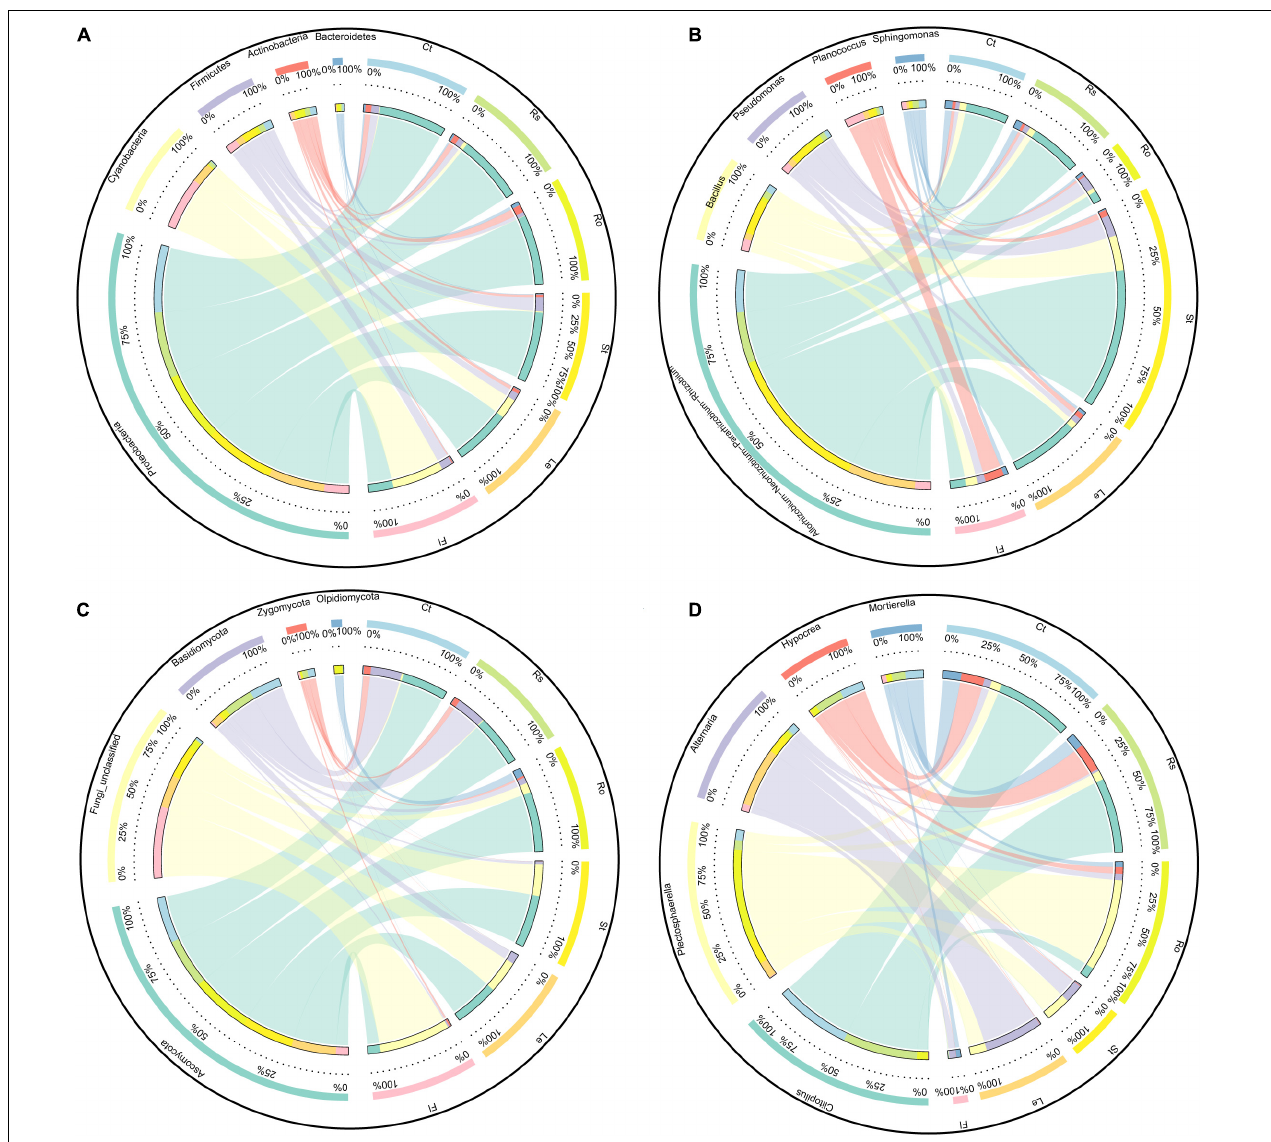
FIGURE 3 | Circos plot showing the distribution proportion of core microbiota among plant compartments. (A) Core bacterial phyla. (B) Core bacterial genus. (C) Core fungal phyla. (D) Core fungal genus. Ct, Rs, Ro, St, Le, and Fl represent bulk soil, rhizosphere soil, root endosphere, stem endosphere, leaf endosphere, and flower endosphere,